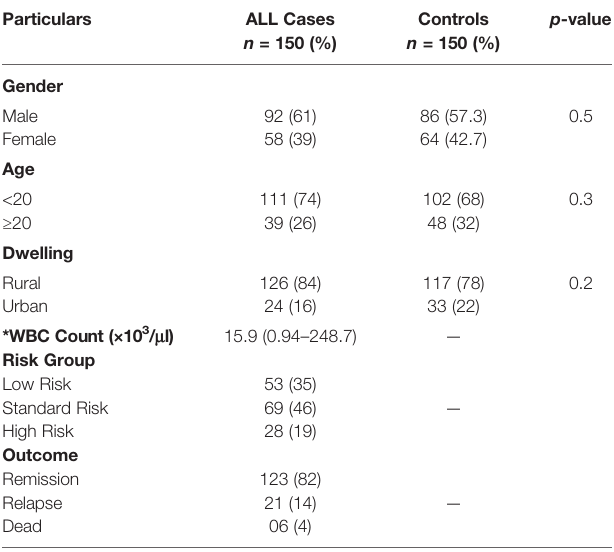
TABLE 1 | Clinical and laboratory parameters along with risk group categorization of ALL patients and healthy controls. Particulars